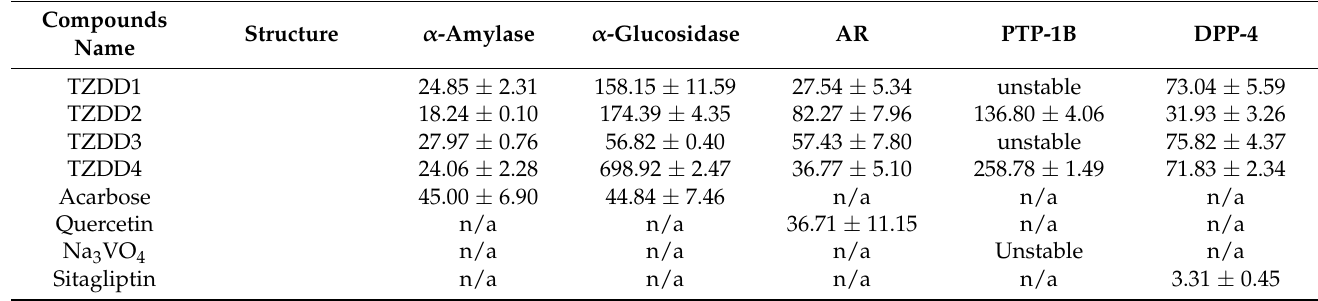
Table 1. Calculated IC 50 values for the TZD derivatives investigated, from the α -amylase, α - glucosidase, aldose reductase, PTP-1B, and DPP-4 inhibitory activity assays, n/a stands for not applicable.